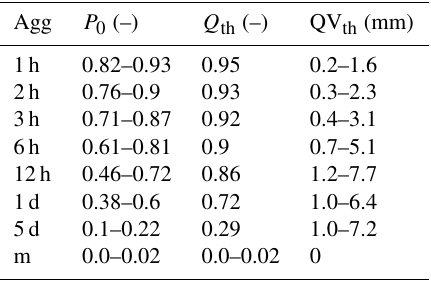
Table 1. The basic rainfall information of the study region for differ- ent aggregations (agg): P 0 is the probability of 0mm rainfall, Q th stands for the defined quantile thresholds or the threshold ranges and QV th represents the corresponding quantile values (rainfall) for the defined Q th